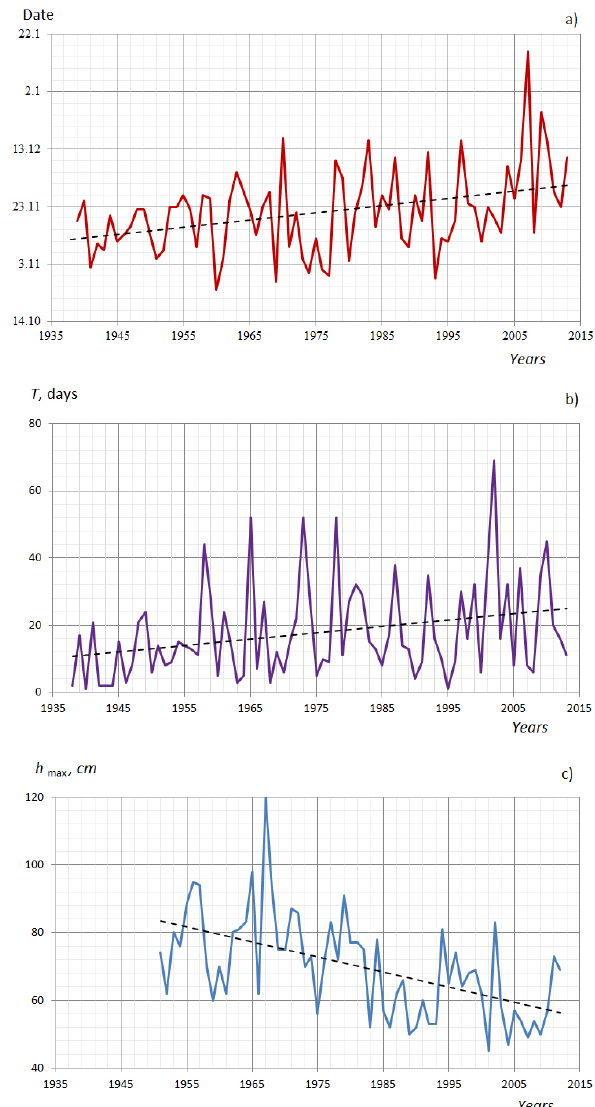
Figure 3. Changes in freeze-up date (a) and the duration of the freezing period (b) , maximum of ice thickness on the Northern Dvina at Velikiy Ustyug (c) (dashed lines indicate linear